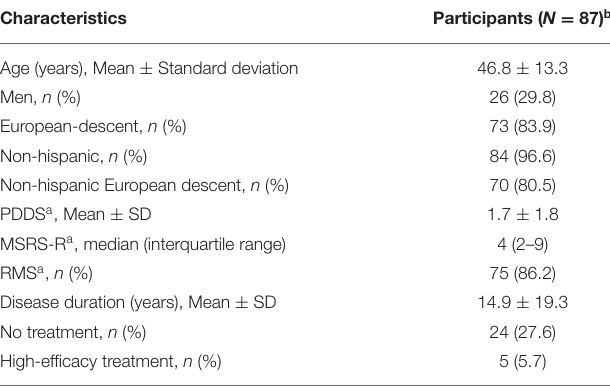
TABLE 1 | Characteristics of the study participants.